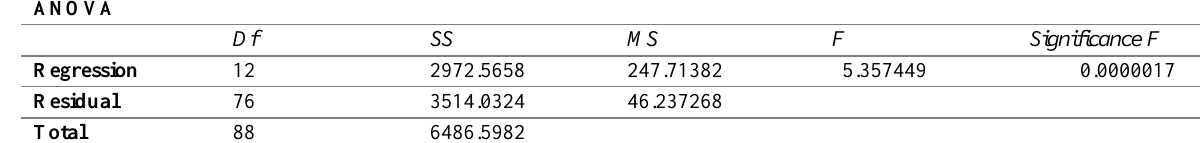
Table11 - ANOVA (Dhaka Division)